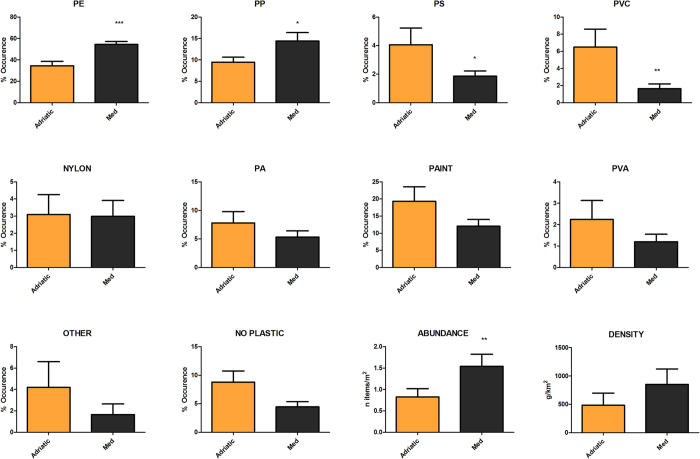
Differences between Adriatic (orange) and western Mediterranean samples (black) in the relative frequencies of the most common types of polymers identified through FT-IR analysis (n = 4,050 particles).Differences in the mean total abundance (items/m2) and density (g/km2) of particles collected are also shown in the last two panels.